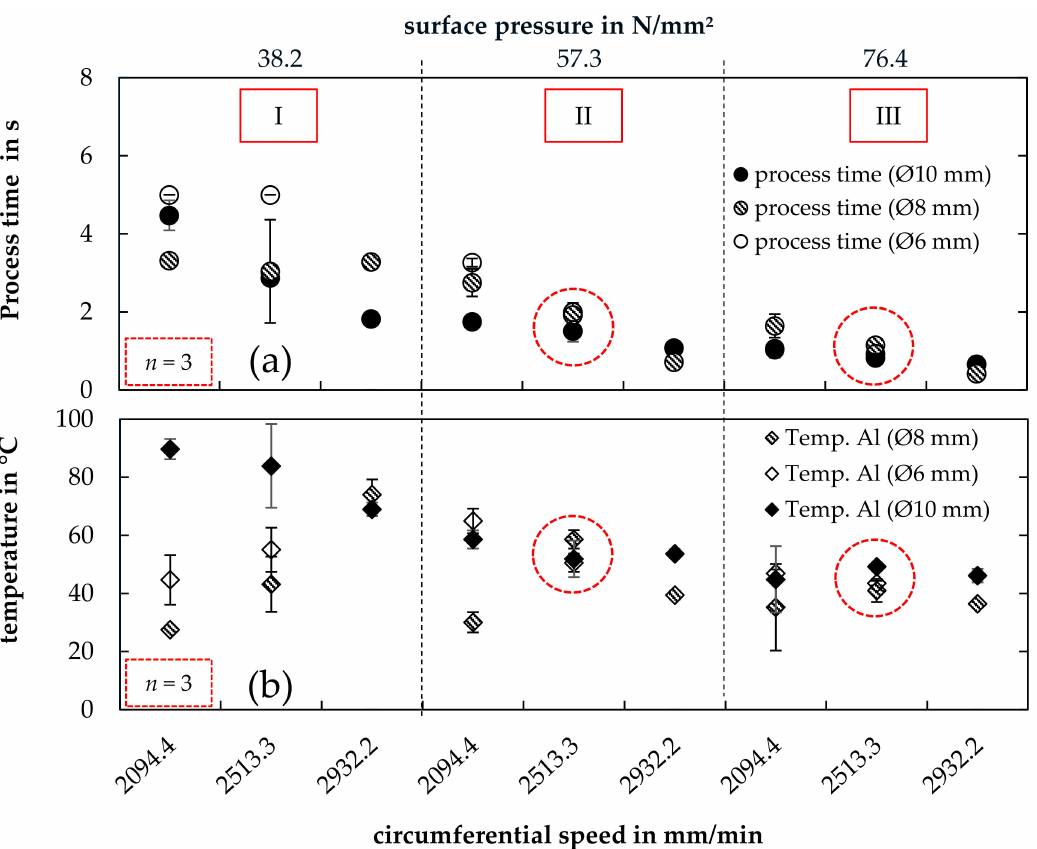
Figure 15. Effects of tool downscaling on the process time ( a ) and heat propagation ( b ).